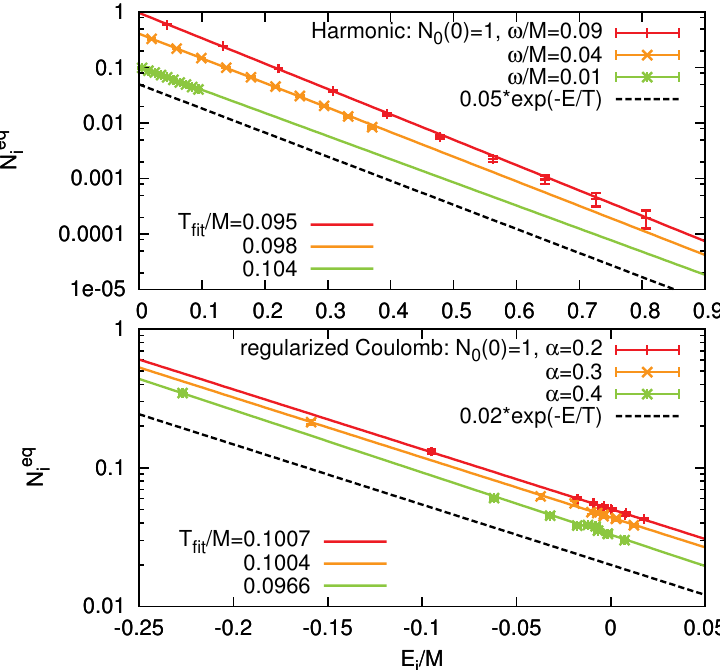
Figure 5 . Equilibrium occupation of the lowest ten eigenstates for the harmonic potential (upper panel) and the regularized Coulomb potential (lower panel). The parameters are varied as !=M = 0 : 01 ; 0 : 04 ; 0 : 09 for the harmonic potential and (cid:11) = 0 : 2 ; 0 : 3 ; 0 : 4 and r c = 1 =M for the regularized Coulomb potential. The bars denote statistical errors. The data are (cid:12)tted by C (cid:1) exp( (cid:0) E i =T (cid:12)t ) and the dashed lines indicate the slope of a Boltzmann distribution with T = 0 : 1 M .